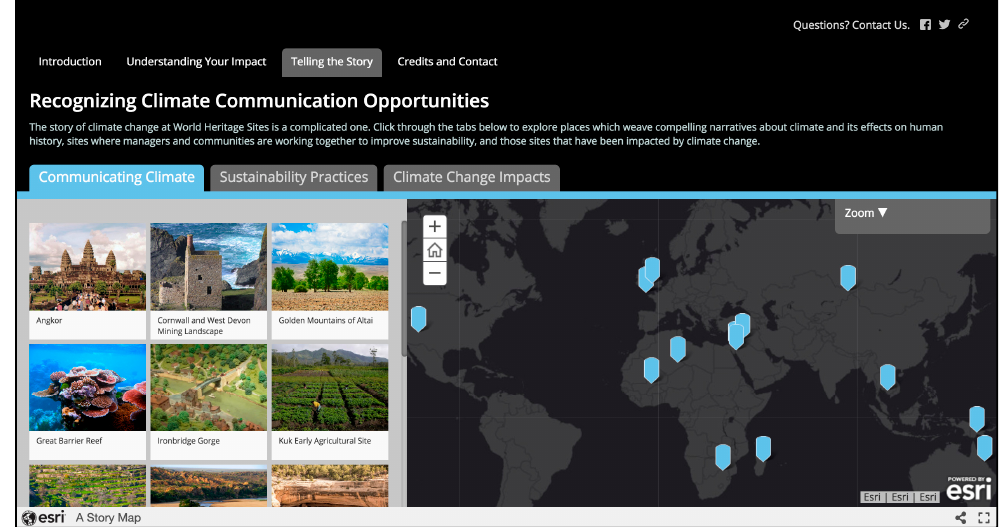
Figure 4. Webpage screenshot of Telling the Story theme in the StoryMap Climate Footprints of Heritage Tourism [41].